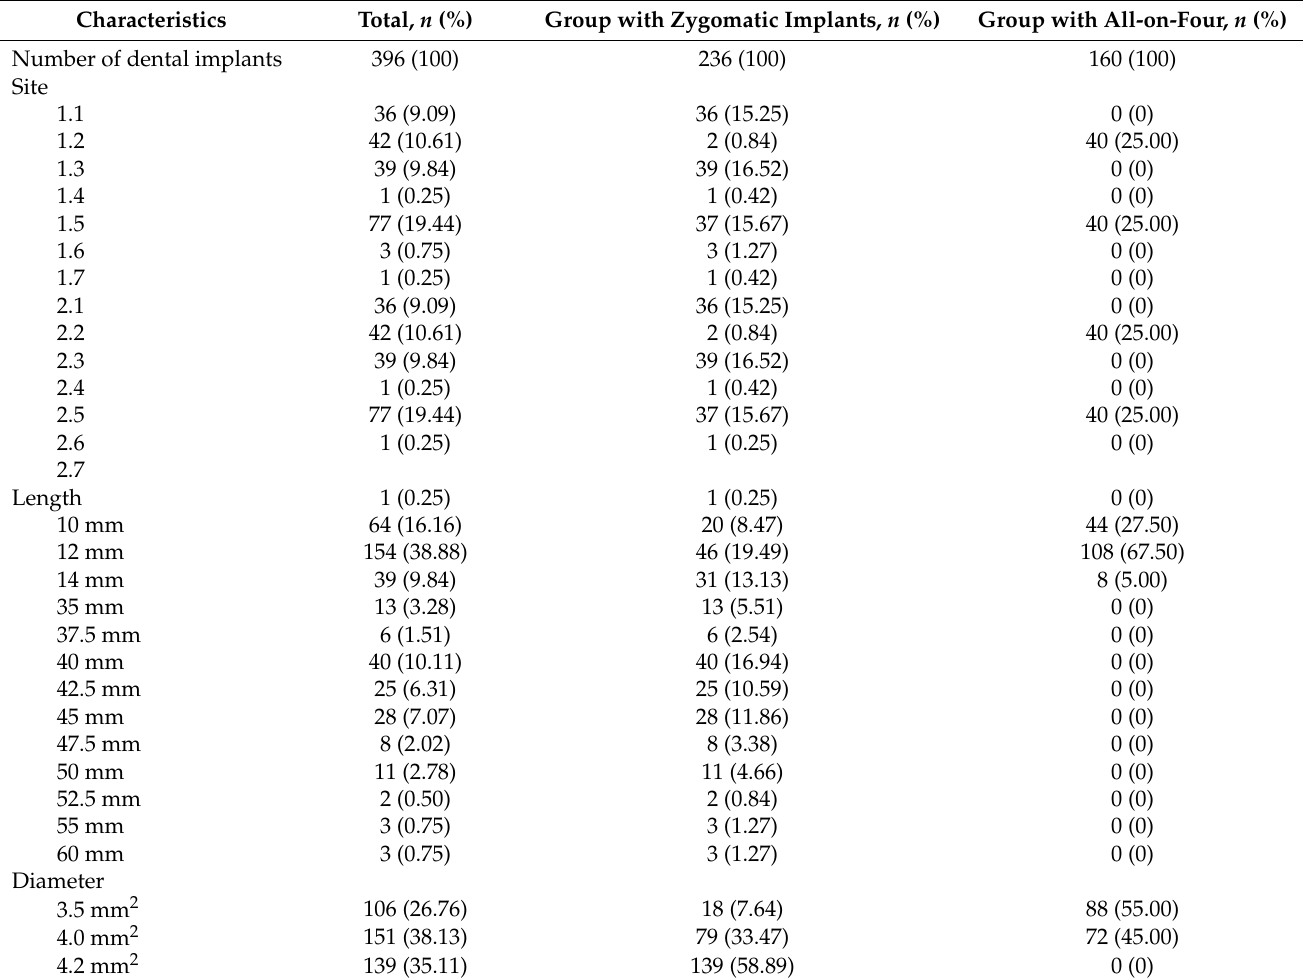
Table 2. Implant